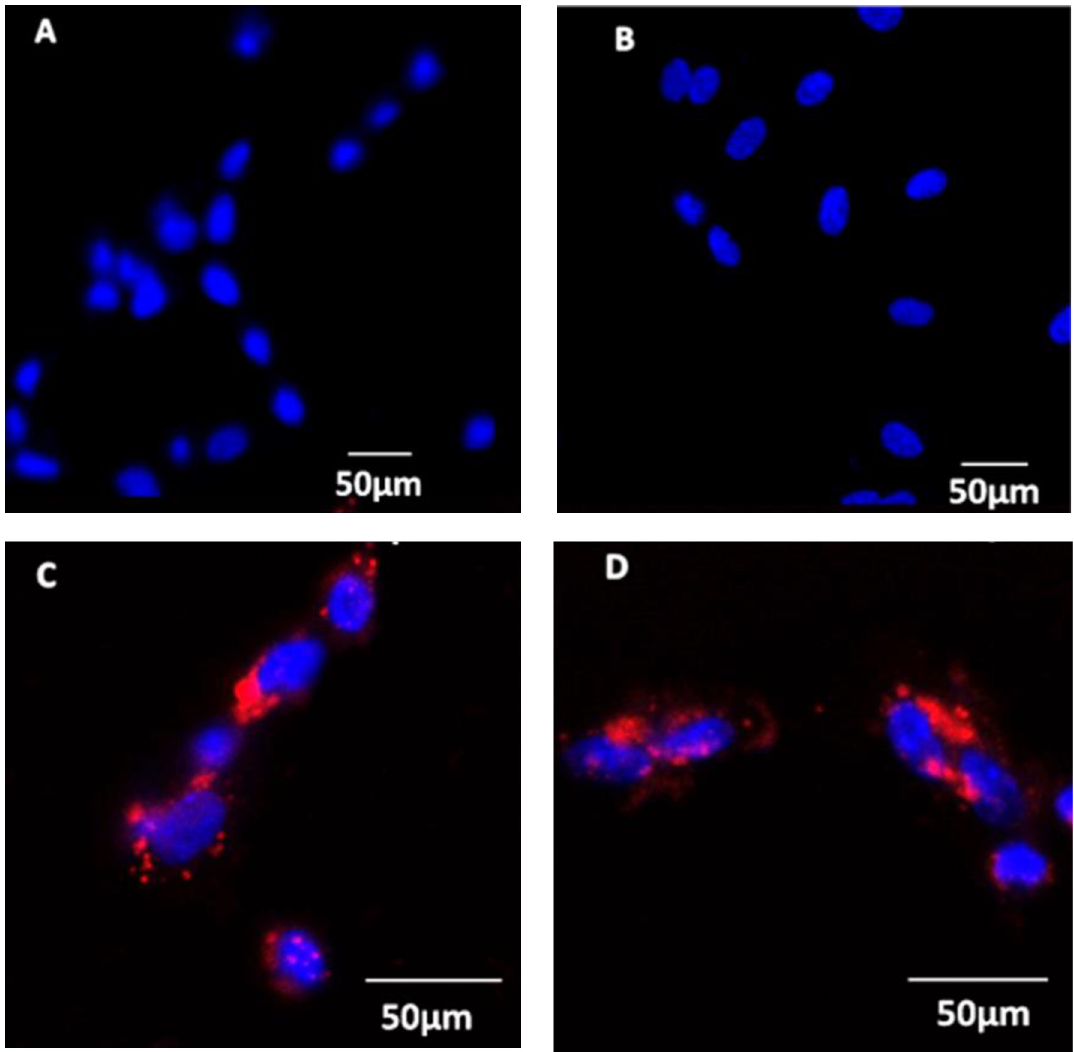
Fig 3. To determine the effect of medium-term culturing of HUVEC on NOP expression, HUVEC cell line PN8 (which required 100ng/ml LPS/PepG treatment to demonstrate NOP expression) was cultured alongside HUVEC cell line PN5 (which demonstrates expression independent of LPS/PepG treatment) and probed with 100nM N/OFQ ATTO594 . In this example at passage 3 (without LPS/PepG treatment), N/OFQ ATTO594 failed to bind to PN8 (A) but demonstrated binding to PN5 (C). After 20 passages, untreated PN8 (B) again failed to bind N/OFQ ATTO594 , while PN5 (D) again demonstrated